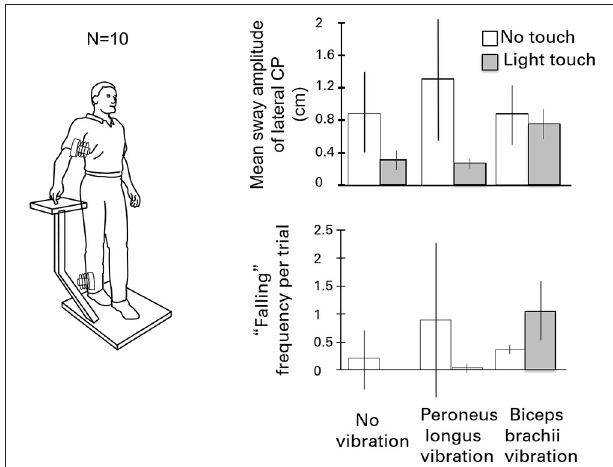
FIGURE 6 | The effects of eliciting tonic vibration reflexes in the peroneus longus muscle of the standing subject’s right leg or in the biceps of the right arm are shown for the different touch conditions. Vibrating the peroneus longus destabilizes subjects and can evoke falling. Light touch fully eliminates the effect. By contrast, during light-touch, biceps vibration is destabilizing and can induce falling or protective